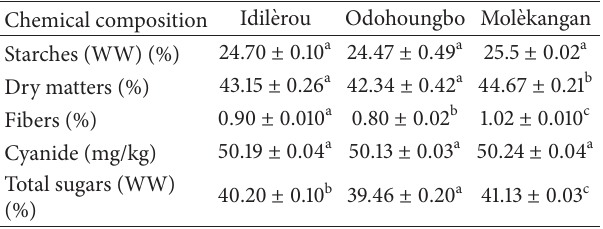
Table 4: Physicochemical composition of the three most preferred cassava elite